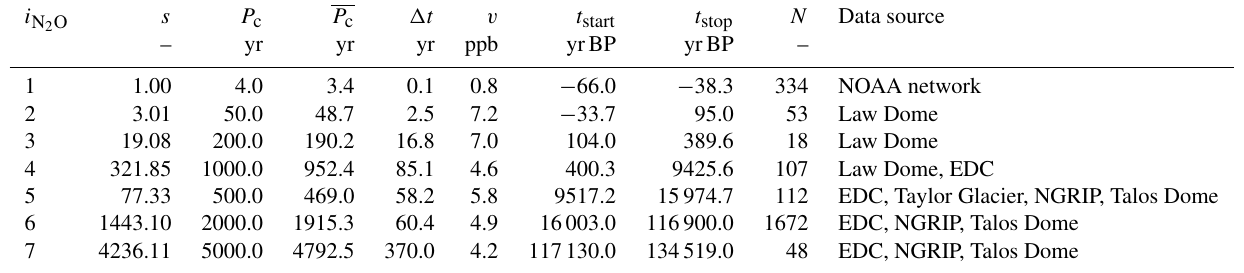
; s : scaling factor to fulfil the constraints given by the prescribed cutoff period P c ; P c : Table 8. Statistics of N 2 O spline. Interval: i N 2 O average realised cutoff period; (cid:49)t : mean data spacing; v : mean 1 σ error – exact time framing is given by the age of the first ( t start ) and last ( t stop ) data point of the interval (in years BP); N : number of data points within interval. In the last column the underlying data source is briefly mentioned; see Table 7 for details and